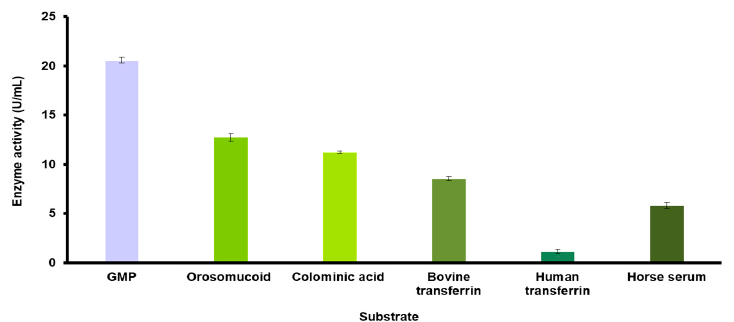
Table 2. Linkages that are attacked by sialidase enzymes in different